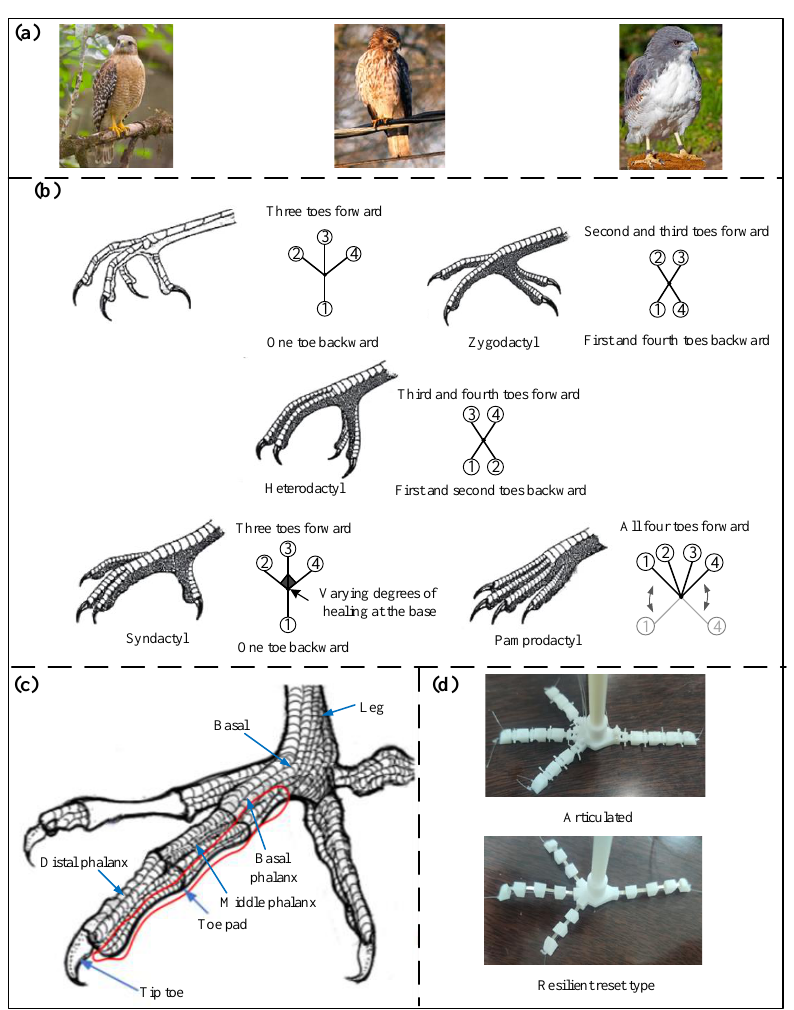
Figure 1. Bird claw bionic principle. ( a ) Bird perching surface; ( b ) claw toe arrangement; ( c ) basic component structure of a bird claw [19]; ( d ) two bionic claw structures.